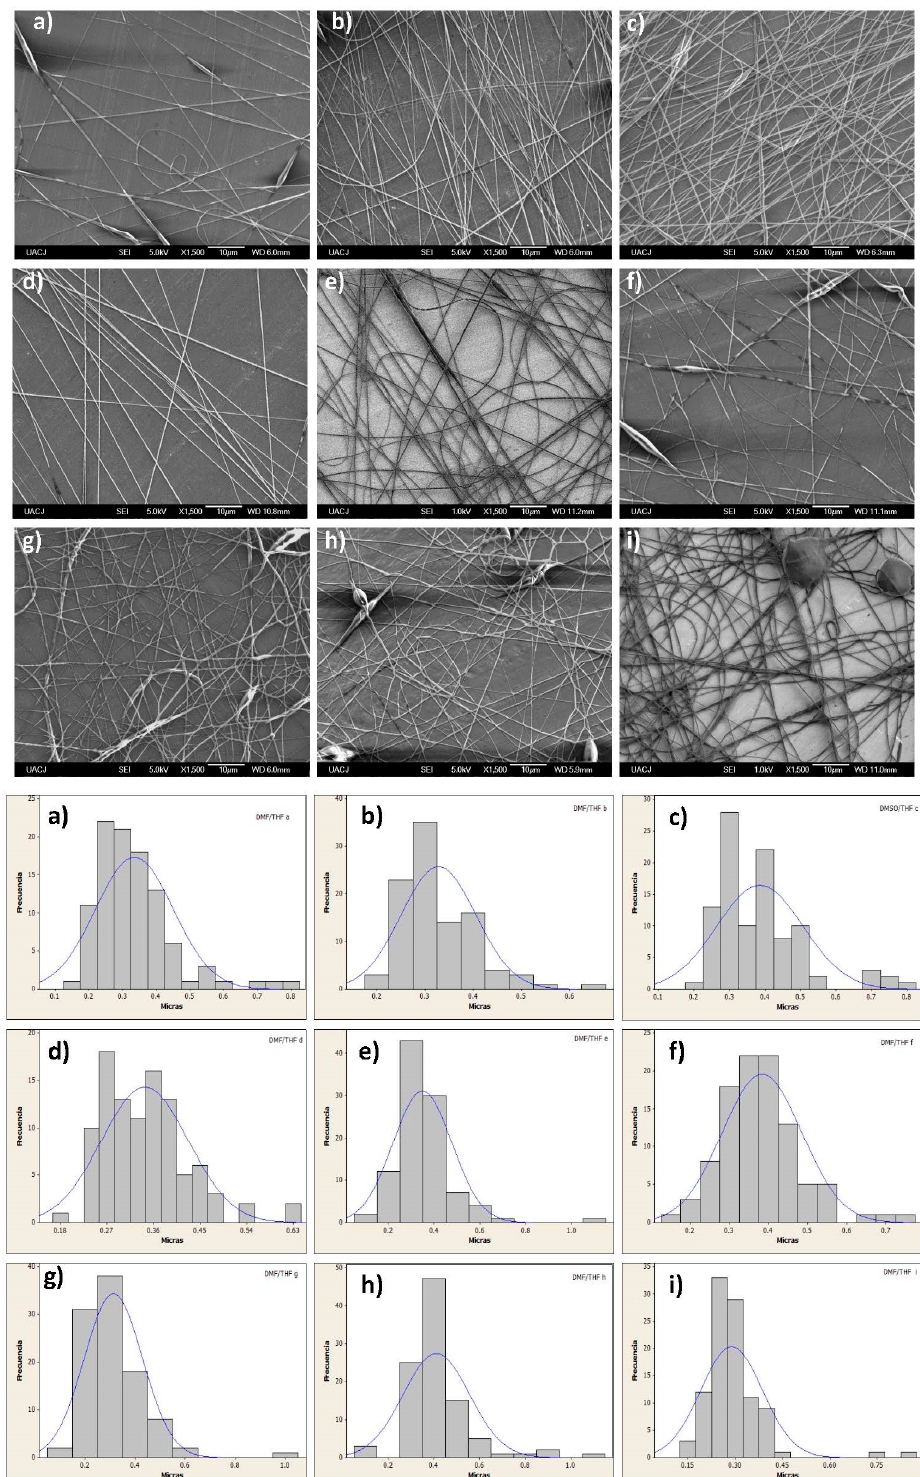
Figure 9. Optimization process of PCL (12%) electrospun in DMF:THF (dimethylformamide:tetrahydrofuran) ( a ) 10 kV, 0.7 mL/h, 18 cm; ( b ) 10 kV, 0.7 mL/h, 14 cm; ( c ) 10 kV, 0.7 mL/h, 10 cm; ( d ) 10 kV, 0.5 mL/h, 14 cm; ( e ) 10 kV, 1.2 mL/h, 14 cm; ( f ) 10 kV, 2 mL/h, 14 cm; ( g ) 12 kV, 1.2 mL/h, 14 cm; ( h ) 14 kV, 1.2 mL/h, 14 cm; and ( i ) 16 kV, 1.2 mL/h, 14 cm. SEM images on the ( top ) and size distribution on the ( bottom